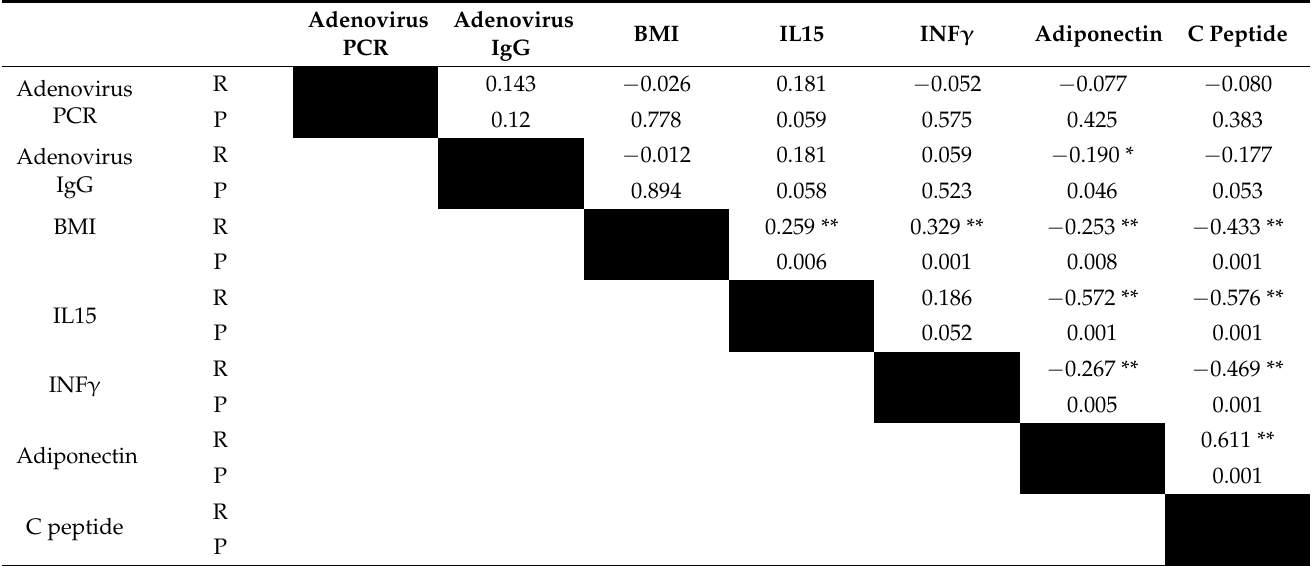
Table 3. Correlation between the existence of adenovirus DNA and anti-IgG and the level of IL15,I NF γ , adiponectin, and C